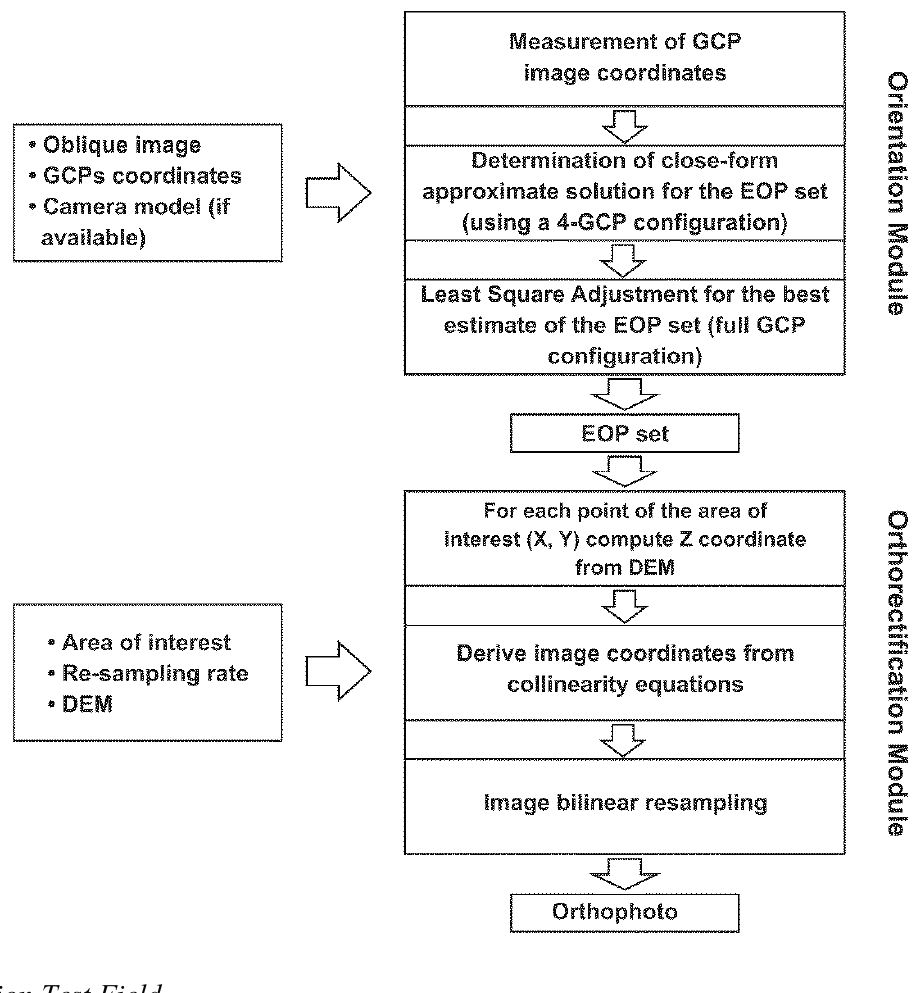
Figure 1. Outline of the algorithms implemented in the Orthoview software: image orientation and image orthorectification modules. EOP stands for External Orientation